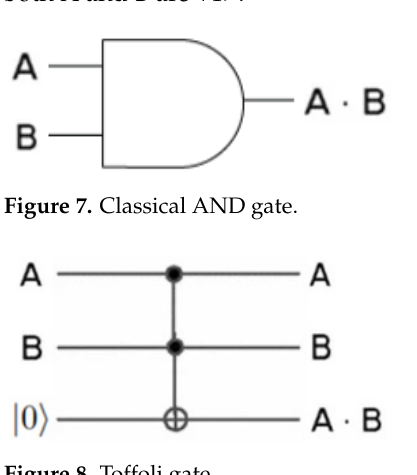
Figure 8. Toffoli